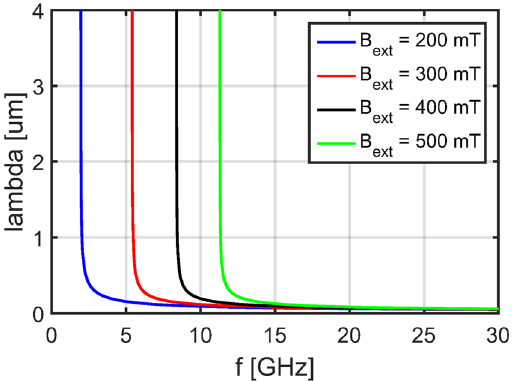
Figure 4. Calculated dispersion relation of spin waves in an out-of-plane magnetized YIG thin film assuming various external